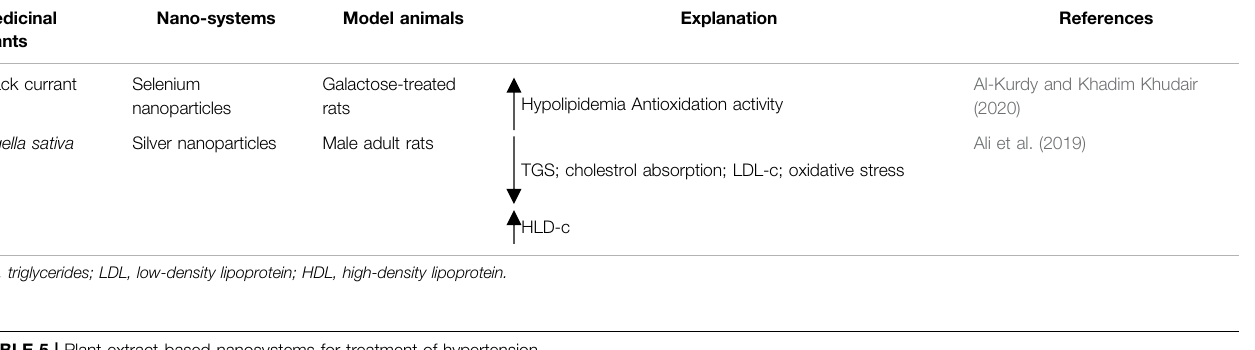
TABLE 5 | Plant extract-based nanosystems for treatment of